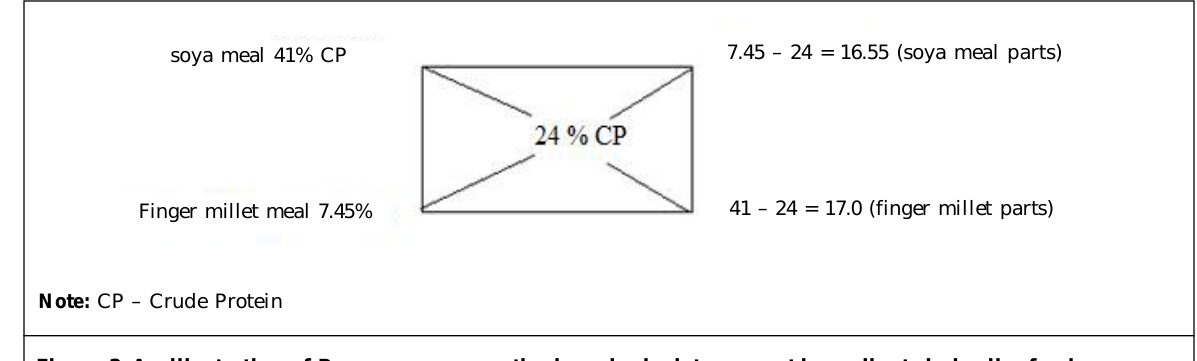
Figure 2: An illustration of Pearson square method used calculate percent ingredients in broiler feed (Wagner and Stanton,